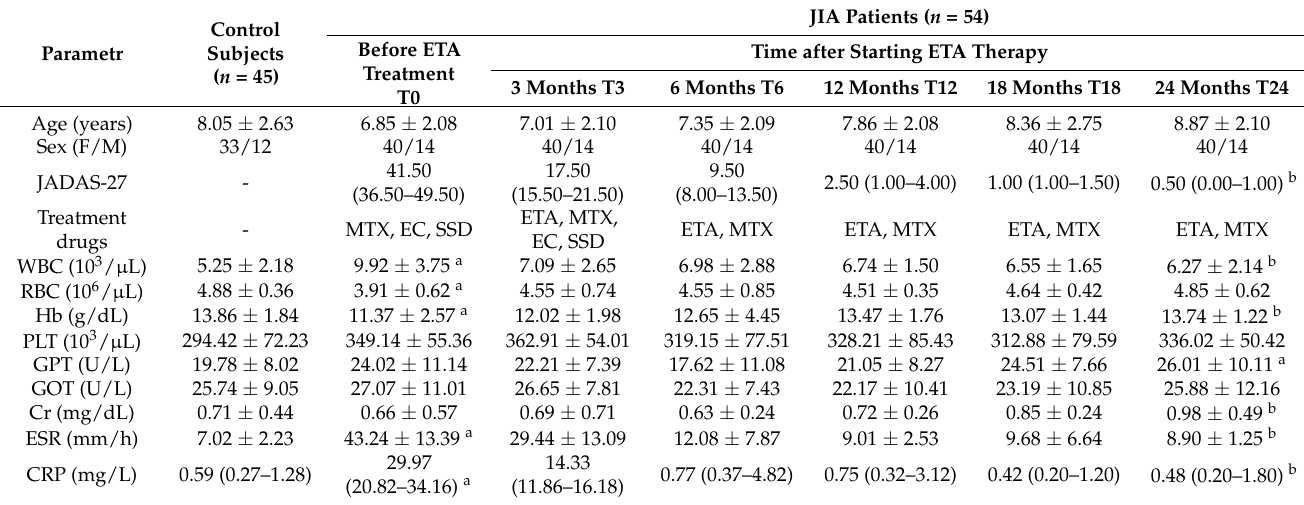
Table 1. The clinical data of control subjects and JIA